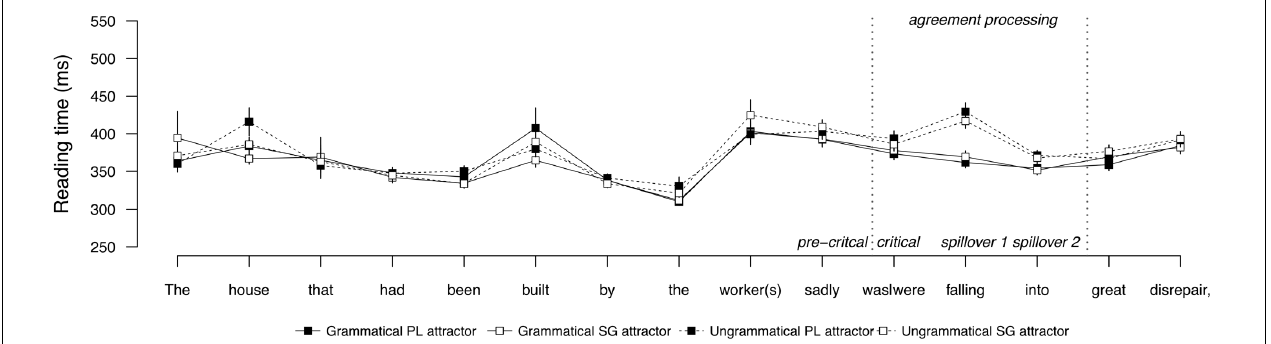
FIGURE 5 | Word-by-word reading times for Experiment 3. Error bars indicate standard error of the mean.